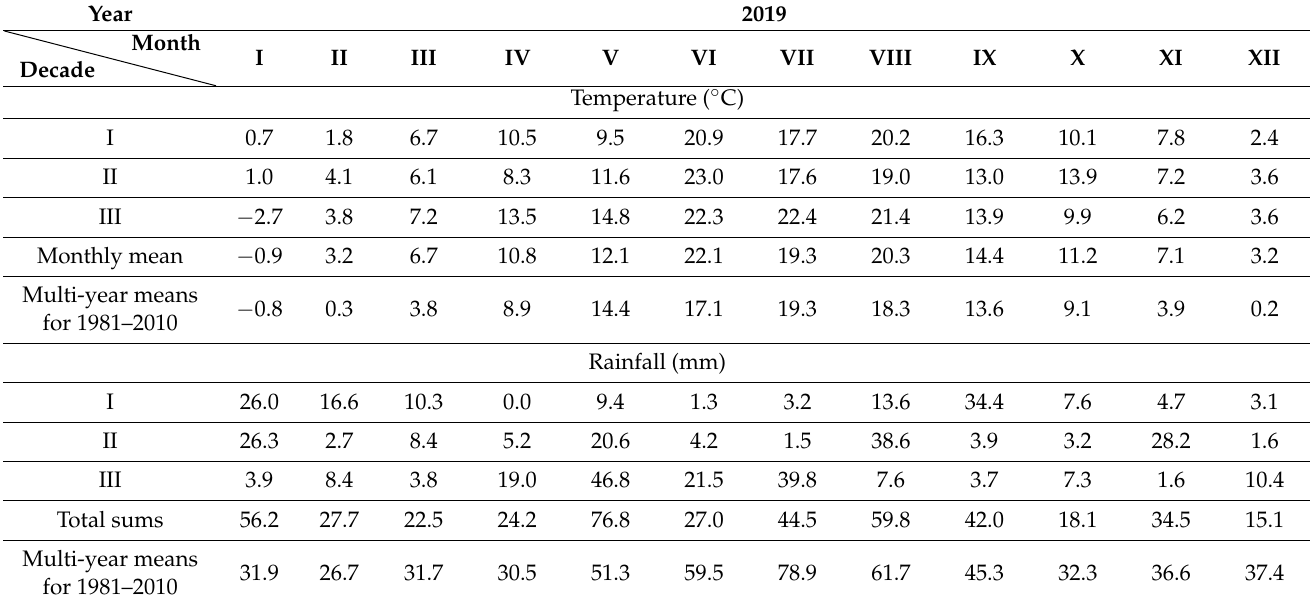
Table 1. Decade, monthly mean air temperatures ( ◦ C), and sums of rainfall (mm) in Pawlowice near Wroclaw